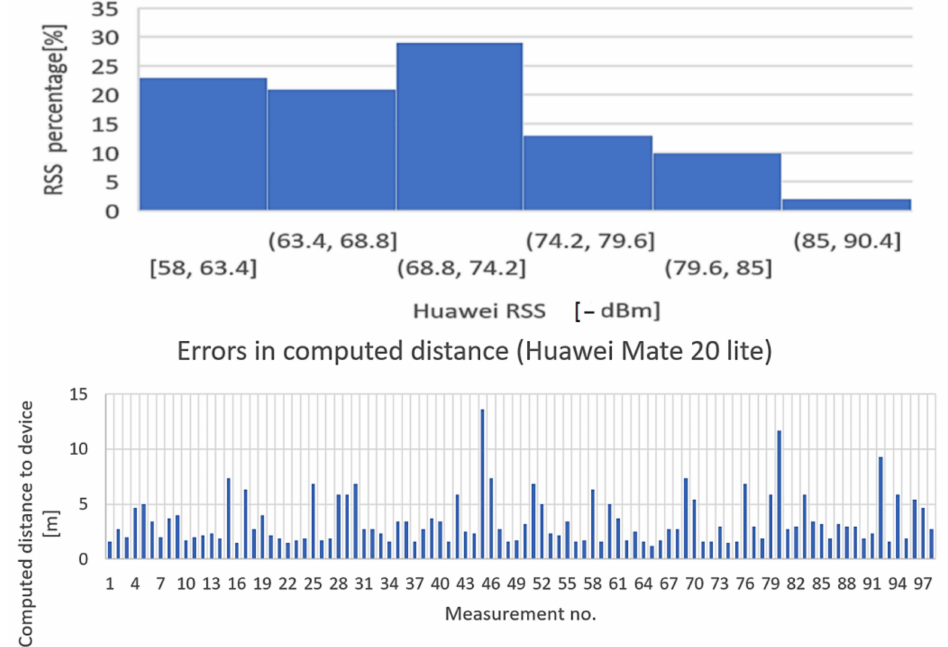
Figure 19. Variation in signal strength for fixed position of mobile station, LoS, d = 1 m. Equipment: Huawei Mate 20 Lite (Histogram + errors in computed distance).